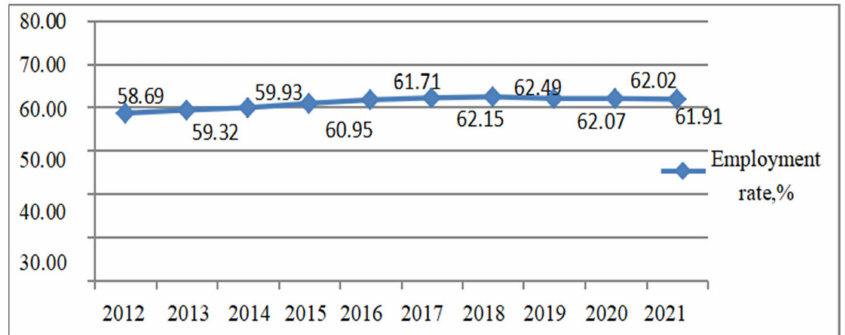
Figure 3. Employment rate of Anhui Province from 2012 to 2021. Data source: compiled and calculated according to the relevant data in Anhui Statistical Yearbooks from 2012 to 2021.